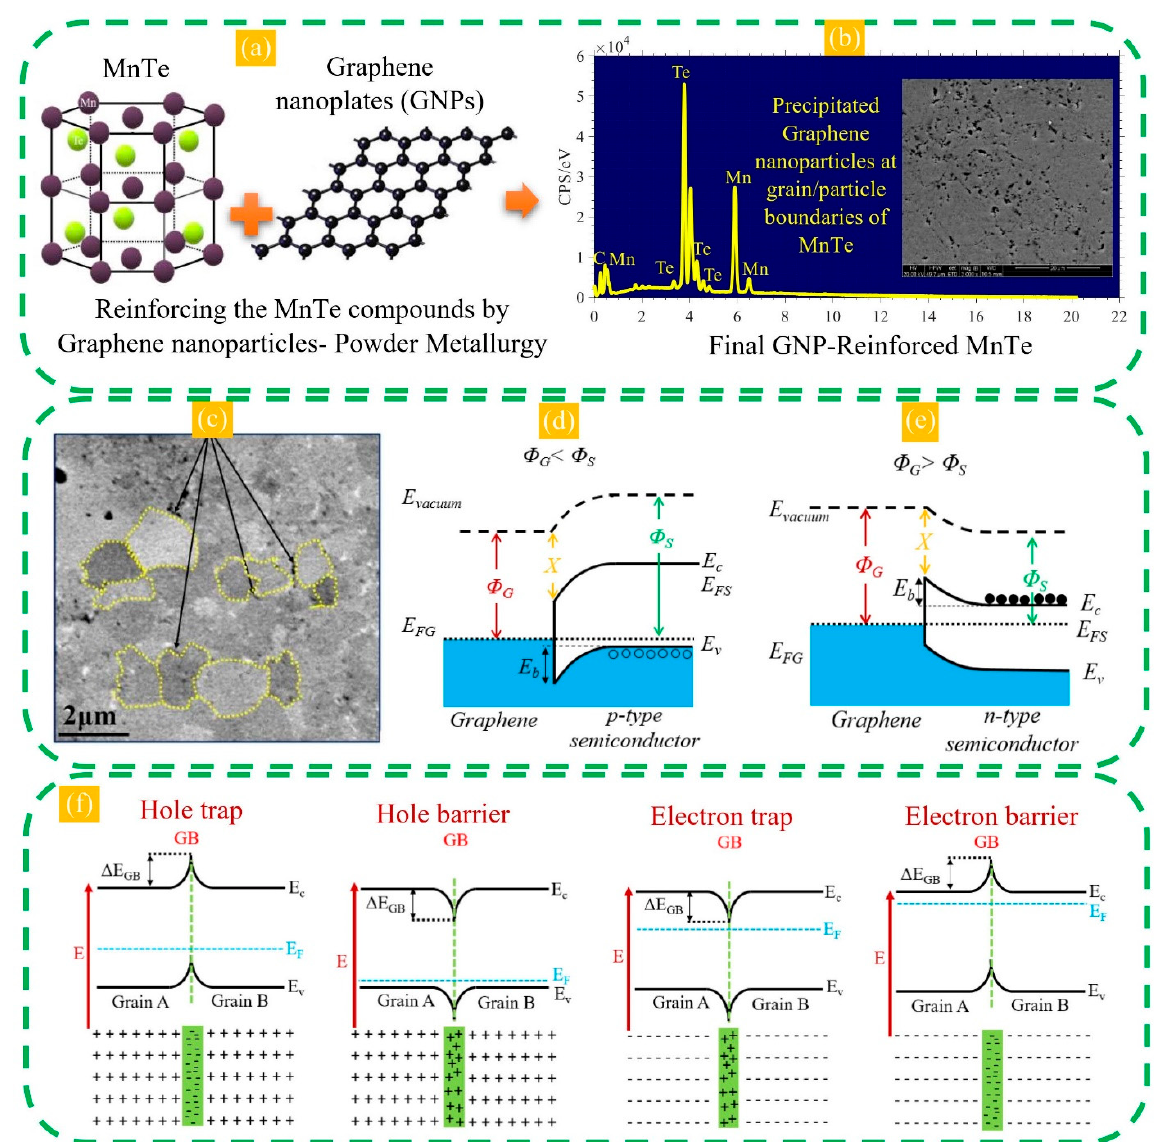
Figure 9. ( a ) Reinforcing MnTe by graphene nanoplates (GNPs) via powder metallurgy, ( b ) GNPs precipitation in the matrix (adapted from [63] with permission), ( c ) GNPs precipitation at microstructural barriers of CoVSn compound (adapted from [28] with permission), ( d ) schematic band alignment of Schottky contact for graphene/n-type semiconductor (adapted from [28] with permission), ( e ) schematic band alignment of Schottky contact for graphene/p-type semiconductor (adapted from [28] with permission), ( f ) schematic diagrams of hole trap, hole barrier, electron trap, and electron barrier generated at grain boundaries (adapted from [28] with permission).